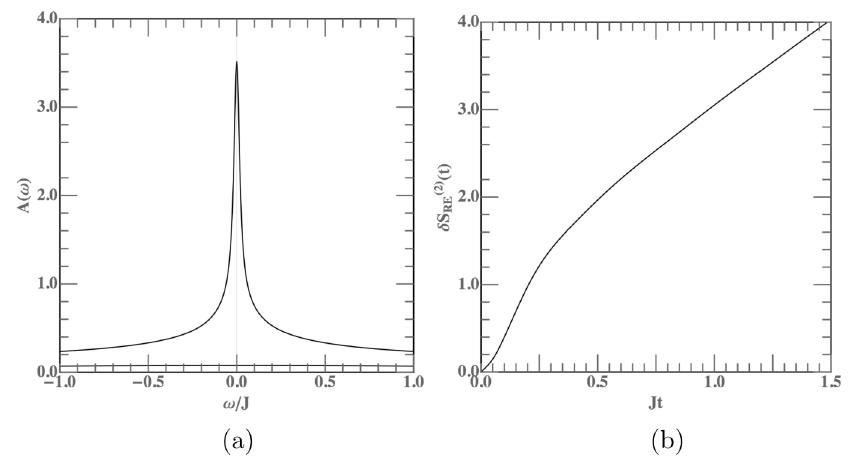
Figure 4 . Heating of the “ Black Hole “. The figure shows the Rényi entropy response of SYK 4 with J = 4 and β = 10 coupling to SYK 2 model with J 0 = 8 and β E = 2 . A short time t 2 growth and a long time t linear growth are